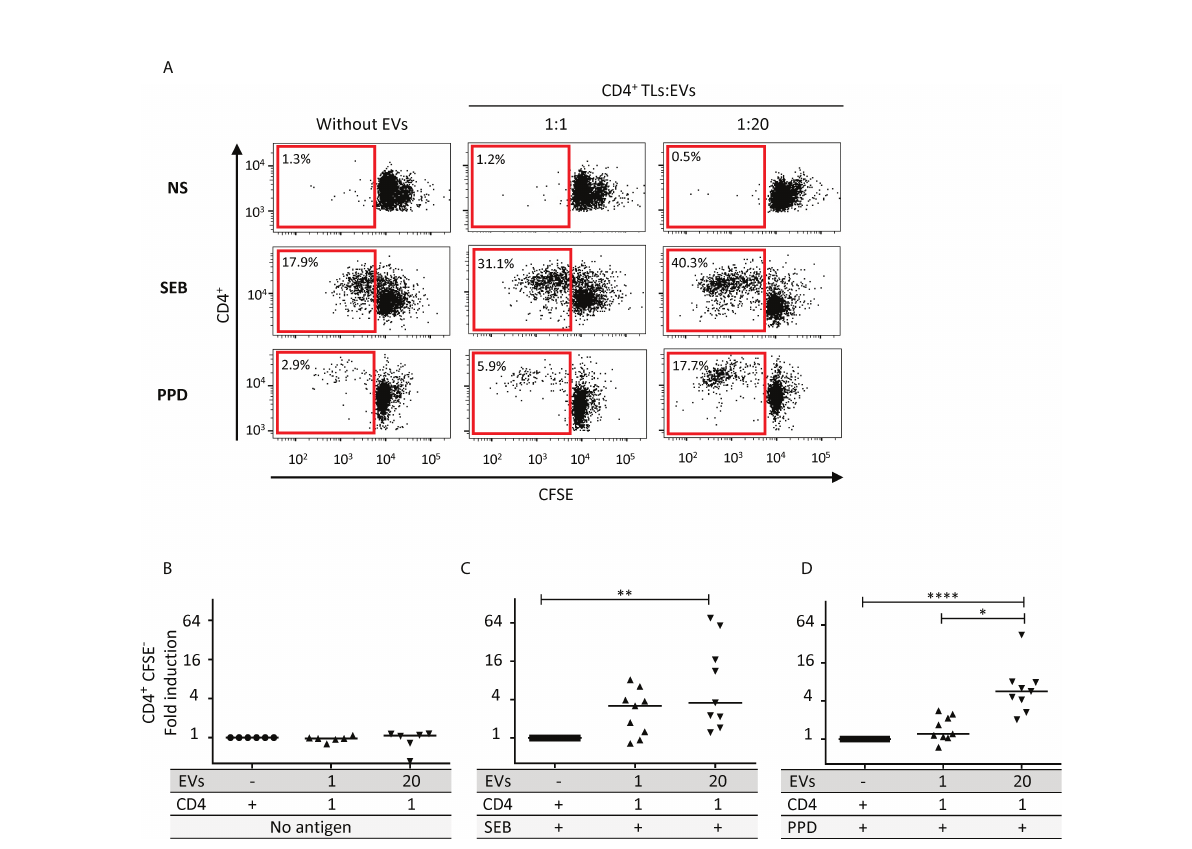
FIGURE 3 Effect of autologous EVs on CD4 + TL lymphoproliferation. (A) Sorted CD4 T cell from HDs were labeled with CFSE and cultured without EVs or with autologous EVs at ratios (CD4: EVs) of 1:1 ( ▴ ) and 1:20 ( ▾ ) for six days in the absence (NS) or presence of antigen (SEB or PPD) at 1 µg/mL. Cell division was assessed after six days of stimulation, by timed acquisition fl ow cytometry analysis for CD4 + CFSE lo T cells. Results from one representative sample are shown. (B) CD4 + TL lymphoproliferation was assessed for six HDs, for sorted CD4 + TLs cultured without EVs ( ○ ) or with total autologous EVs at ratios (CD4: EVs) of 20:1 ( ♦ ), 1:1 ( ▴ ) and 1:20 ( ▾ ) for six days. (C) CD4 + TL lymphoproliferation was assessed for nine HDs, for preparations enriched in CD4 + TLs stimulated with SEB and cultured without EVs ( ▪ ) or with total autologous EVs at ratios (CD4: EVs) of 20:1 ( ♦ ), 1:1 ( ▴ ) and 1:20 ( ▾ ) for six days. (D) CD4 + TL lymphoproliferation was assessed for nine HDs, for PBMCs stimulated with PPD and cultured without EVs ( ▪ ) or with total autologous EVs at ratios (CD4: EVs) of 1:1 ( ▴ ) and 1:20 ( ▾ ) for six days. Horizontal bars indicate the